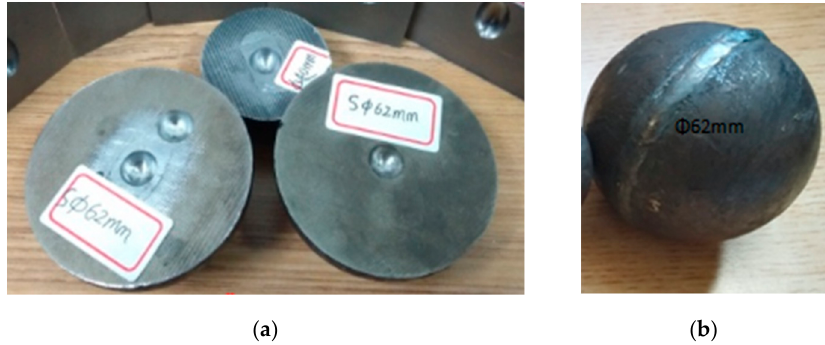
Figure 12. Drilling holes on the cross section of experimental specimens. ( a ) drilling; ( b ) welding together.